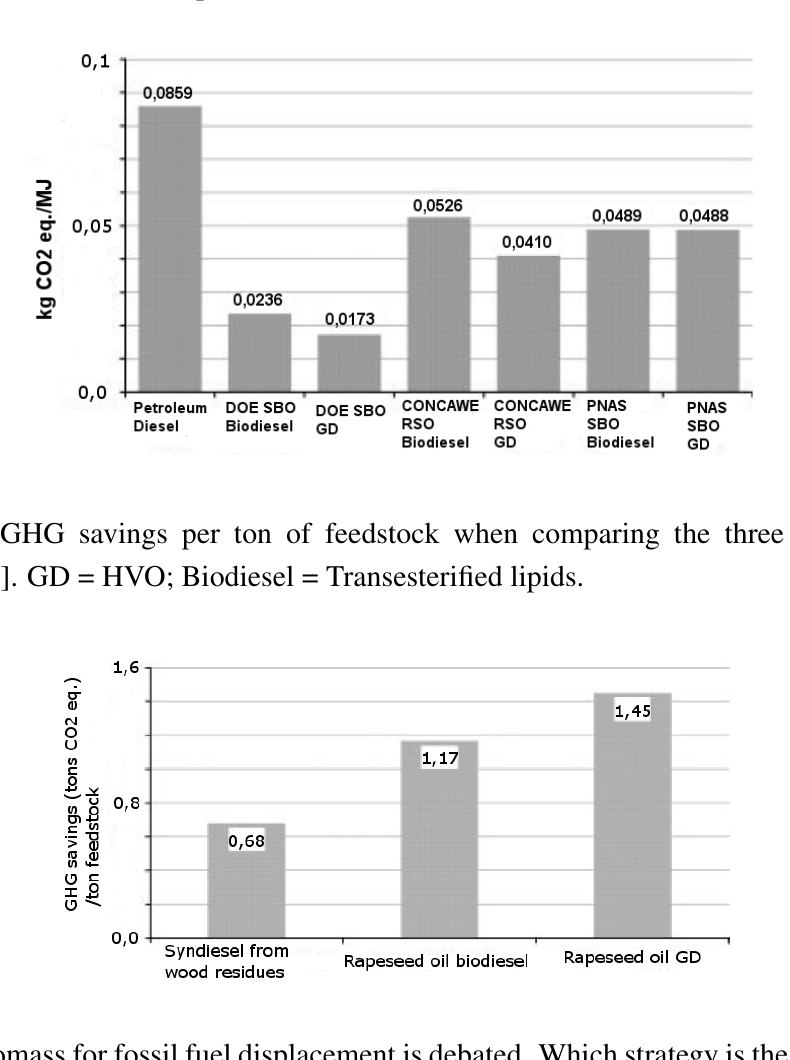
Figure 1. GHG emission comparison between fossil diesel, transesterified lipids, HVO and woody BTL [18]. GD = HVO; RSO = Rapeseed Oil; SBO = Soybean oil; Biodiesel = Transesterified lipids.